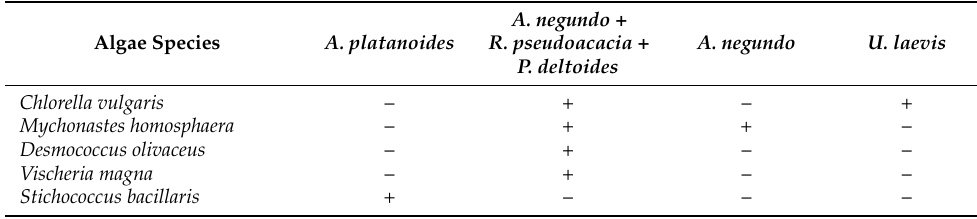
(Table 2). According to the received data, green algae Klebsormidium flaccidum (Streptophyta) was not found in R. kessleri’s body surface washes but was discovered in the gut. Table 2. Taxonomic composition of algae from R. kessleri’s body surface washes in the Y. Haharin park of Dnipro city ( n = 5).